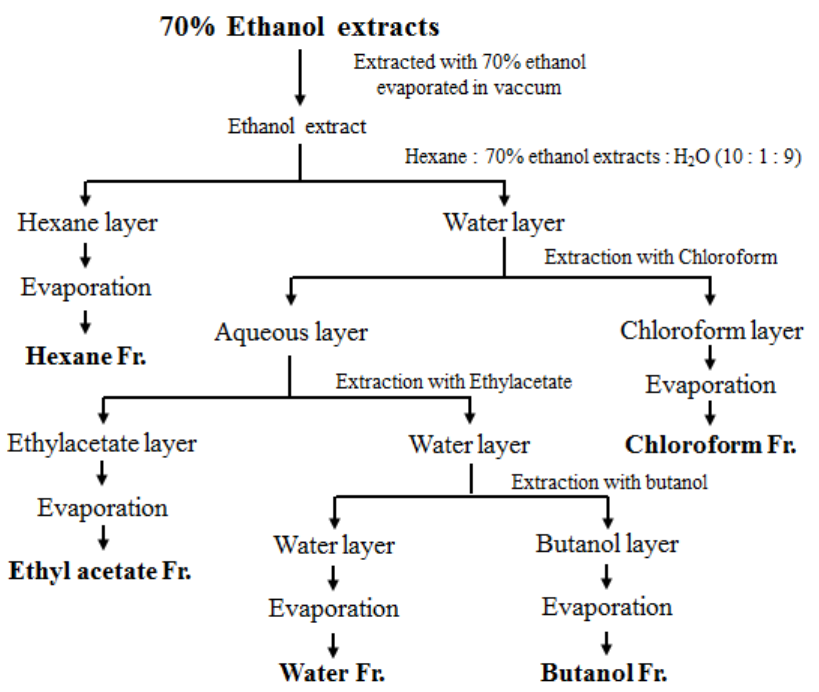
Figure 1. Solvent fractions of skullcap with ethanol, hexane, ethyl acetate, chloroform, butanol, and water.